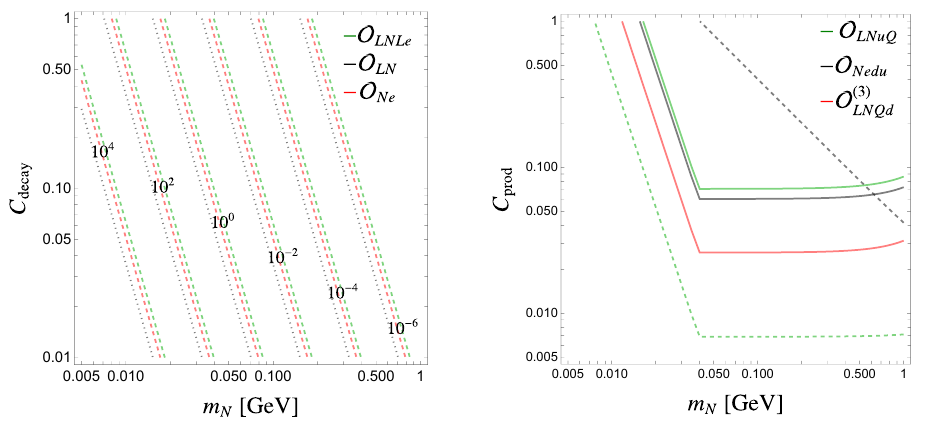
Figure 7 . Left panel: Iso-decay length contours in the lab frame (in meters) for the three decay operators, O LNLe (green), O LN (black), and O Ne (red). Right panel: 5 σ discovery sensitivity for the three production operators, O LNuQ (green), O Nedu (black), and O (3) (dashed) lines are for three-body (two-body) B